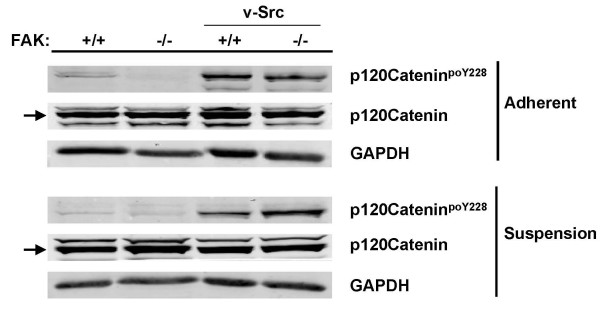
FAK and adhesion modulate v-Src-induced phosphorylation of p120catenin. Lysates from adherent or suspension cultures of FAK+/+[puro], FAK-/-[puro], FAK+/+[v-Src] and FAK-/-[v-Src] cells were probed by IB for total p120catenin, p120cateninpoY228 or GAPDH. These data are typical of at least three independent experiments. Arrows, p120catenin identified by the p120cateninpoY228-specific Ab.